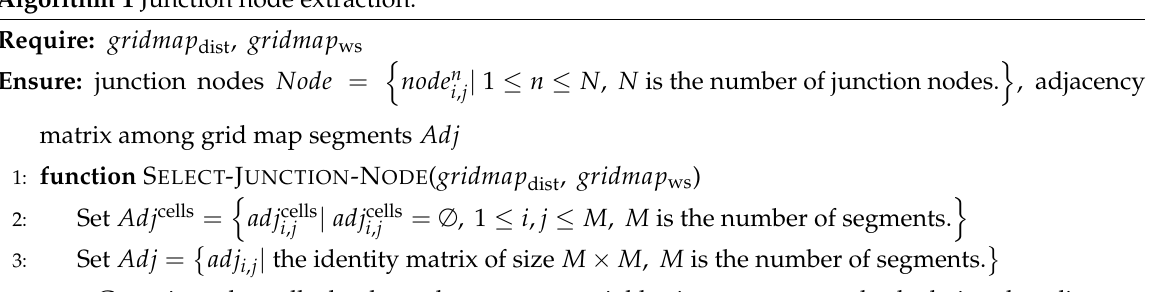
matrix among grid map segments